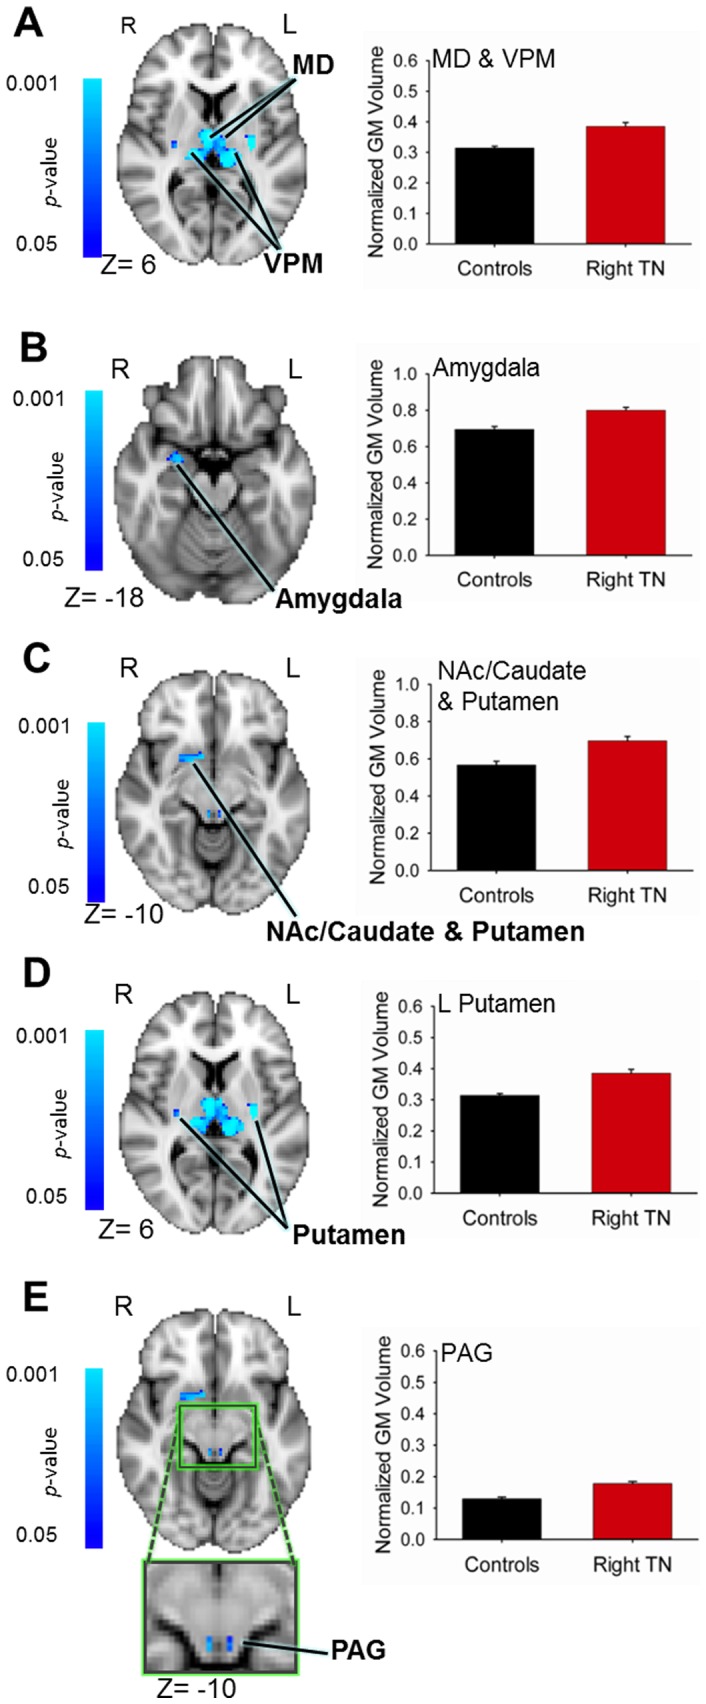
Regions of greater subcortical volume in patients with trigeminal neuralgia.VBM analysis revealed significant group differences in several subcortical brain regions. Significant results (p<0.05, corrected) are displayed on the MNI152 (2 mm) T1 brain template. Blue clusters indicate greater GM volume in patients compared to controls. Graphs of normalized GM volumes ± SEM are shown to the right of brain images: controls (black bars), patients (red bars). Increased patient GM volume was observed in: (A) the sensory thalamus, including the MD and VPM thalamus bilaterally; (B) the right amygdala; (C) a cluster spanning the right nucleus accumbens, anterior putamen and caudate; (D) the posterior putamen bilaterally; (E) the PAG (green box shows magnified region). Abbreviations: R =  right; L =  left; MD =  medial dorsal nucleus (thalamus); VPM =  ventral posterior medial nucleus (thalamus); NAc =  nucleus accumbens; PAG =  periaqueductal gray.